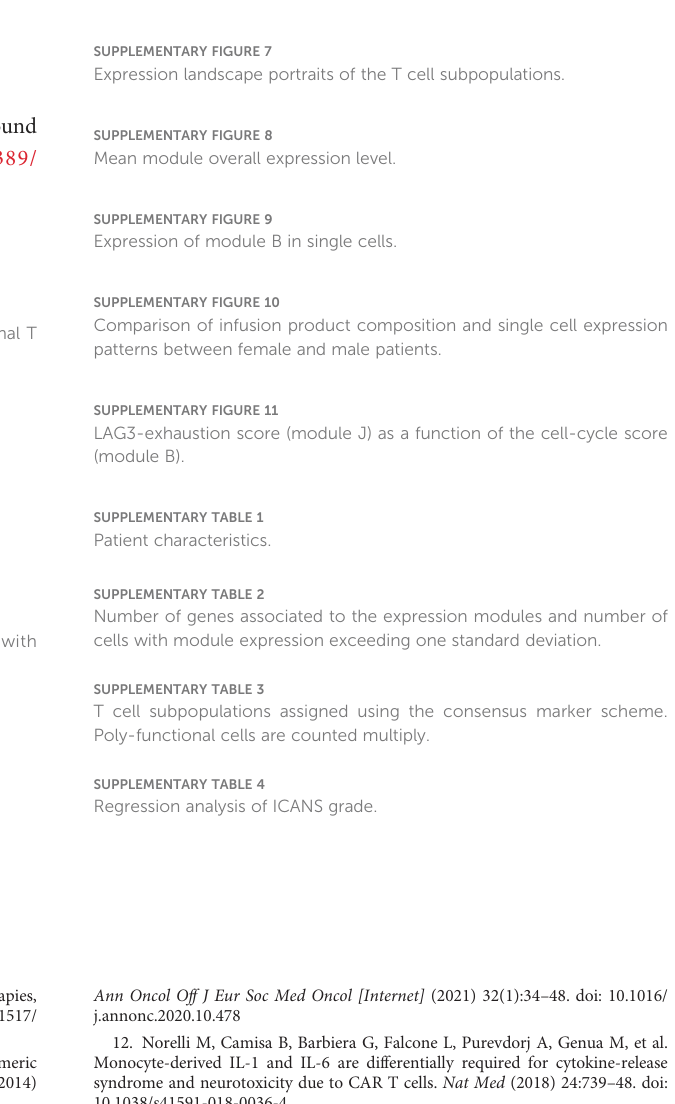
SUPPLEMENTARY FIGURE 10 Comparison of infusion product composition and single cell expression patterns between female and male patients.